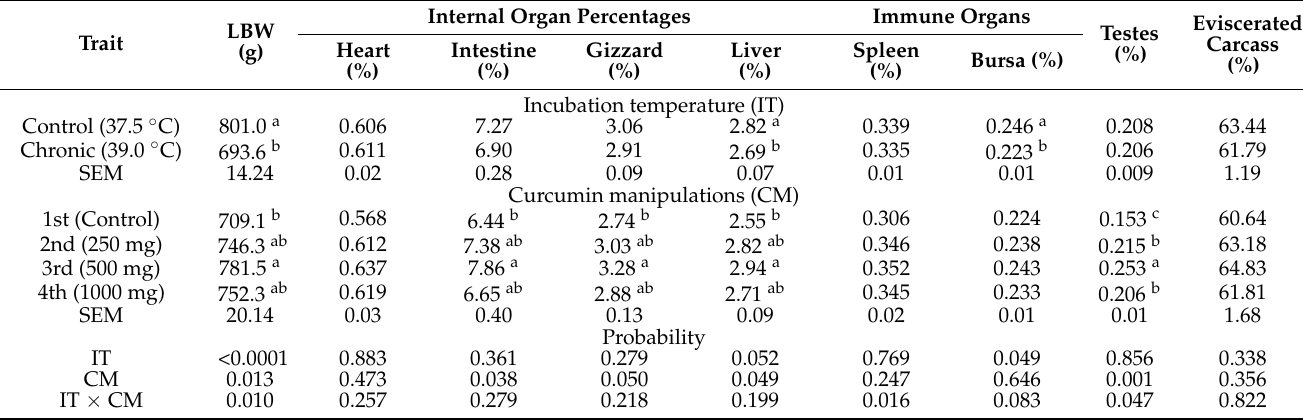
Table 6. Impact of incubation temperature, curcumin manipulations, and their interaction on carcass characteristics of male